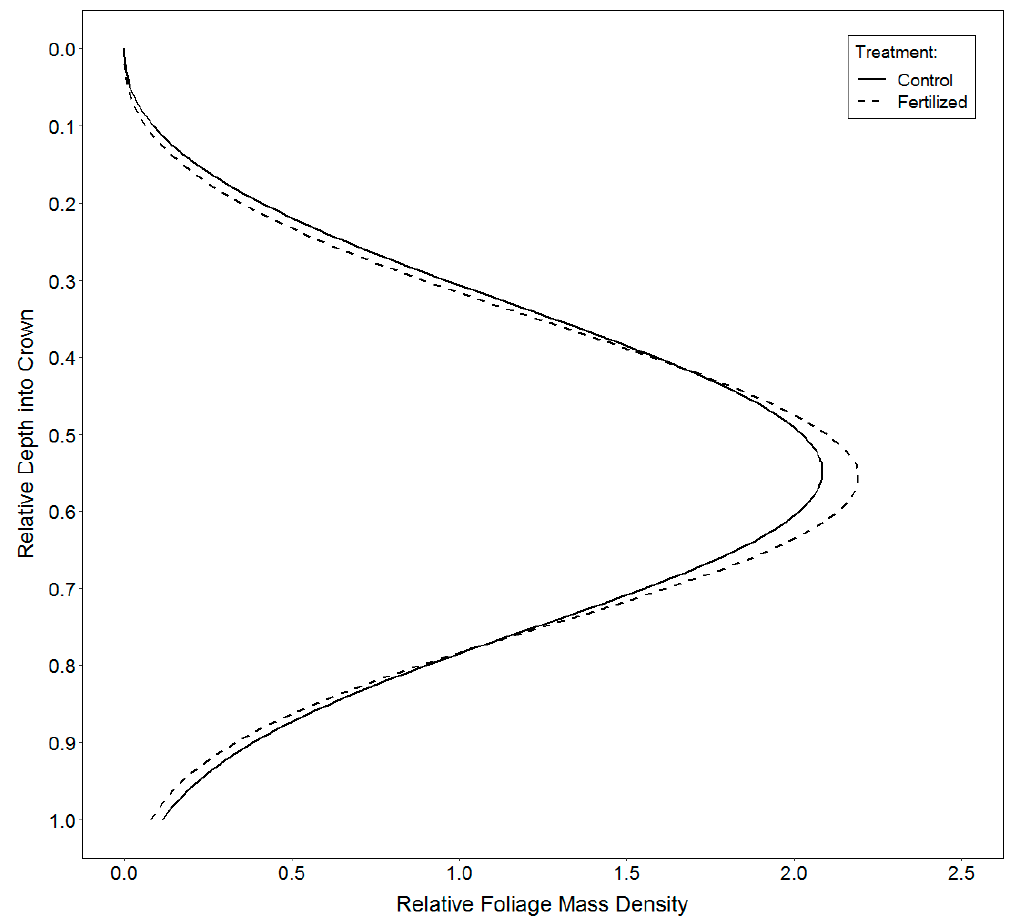
Figure 4. Effect of nitrogen fertilization on vertical foliage distribution over relative depth into crown (RDINC) as modeled with a right-truncated Weibull distribution (control = solid line; fertilized = dashed line). Vertical foliage distribution is represented as relative foliage mass density, or the proportion of total foliage mass per unit relative live crown length. Distributions were standardized to the average tree size in the study (D = 27.50 cm; H = 20.76 m; HCB = 7.28 m; CL = 13.48 m). RDINC = 1 at crown base and RDINC = 0 at tree tip.